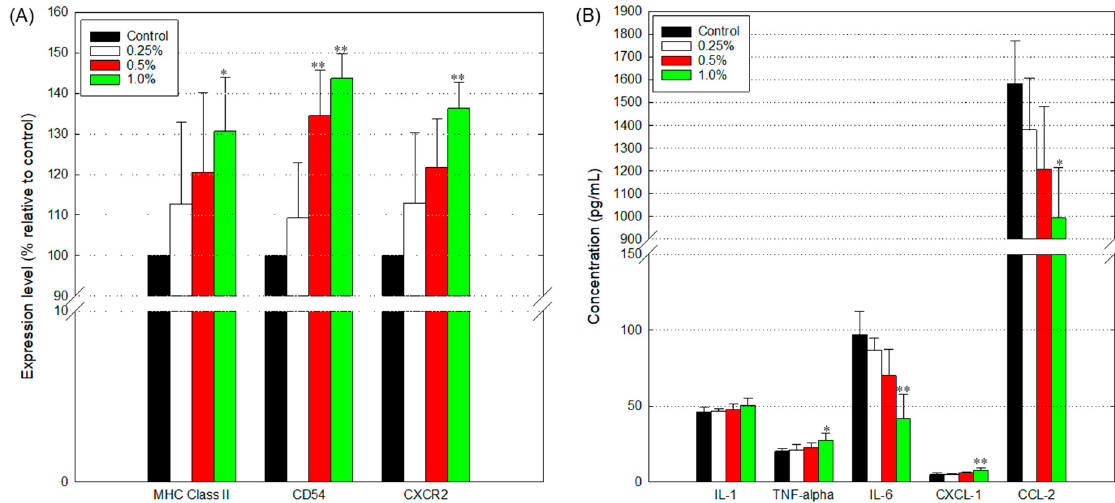
Figure 9. Disturbance in immune cell chemotaxis. Astrocytes were incubated with WCSC (0, 0.25, 0.5, and 1.0%) for 24 h. All the end points were independently tested three times, and the results were presented as mean ± SD. * p < 0.05, ** p < 0.01; ( A ) expression of surface molecules. Overall, 10,000 cells per sample were analyzed using a FACS system, and the surface expression level of each protein was calculated as the relative value compared to the control (100%); ( B ) concentration of cytokines (or chemokines) in the cell supernatants. The concentration was determined using two wells per